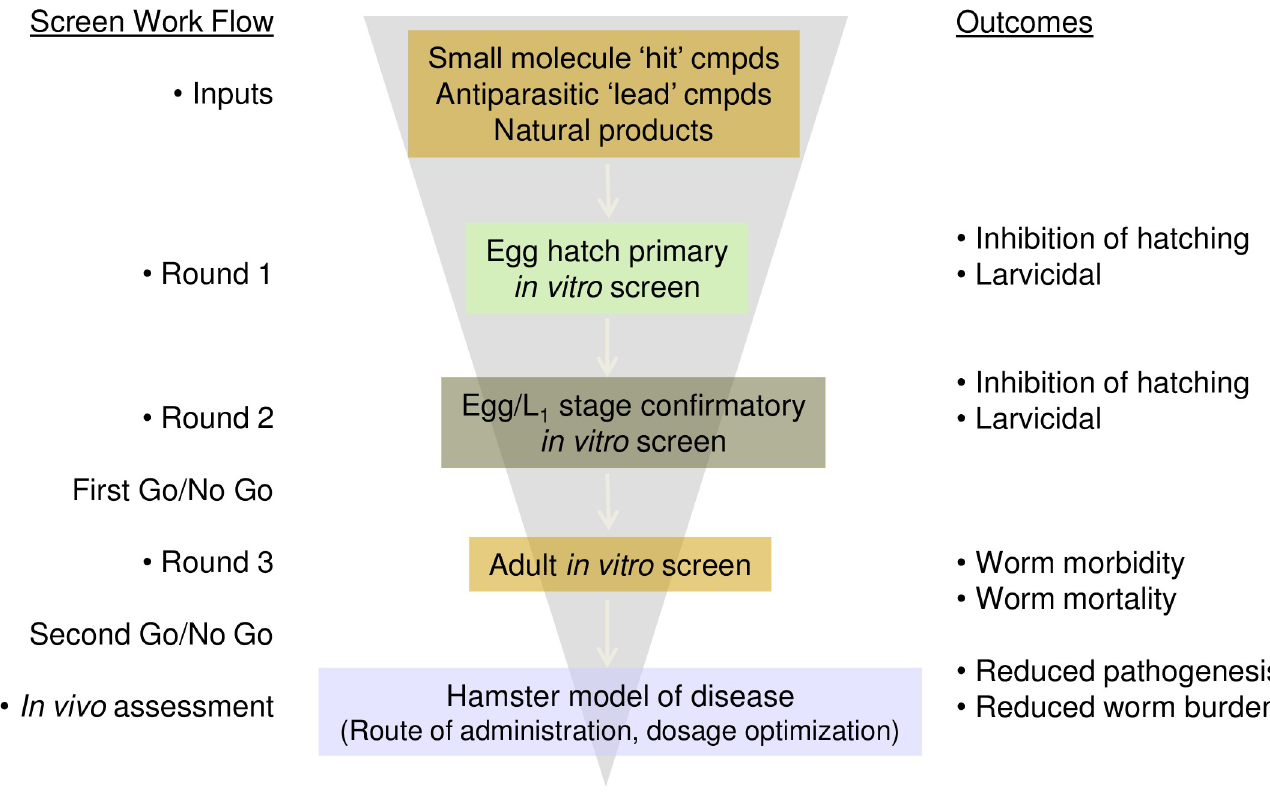
Fig 7. Screen Work